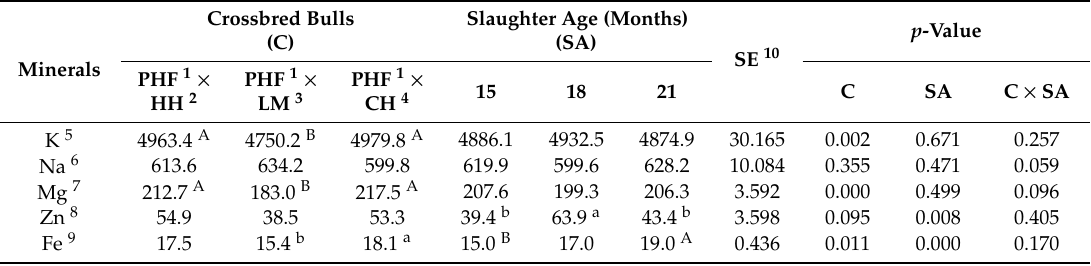
Table 4. Mineral (mg / kg of fresh meat) content of the longissimus thoracis muscle of crossbred bulls. Crossbred Bulls Slaughter Age (Months) p (C) (SA) SE 10 Minerals